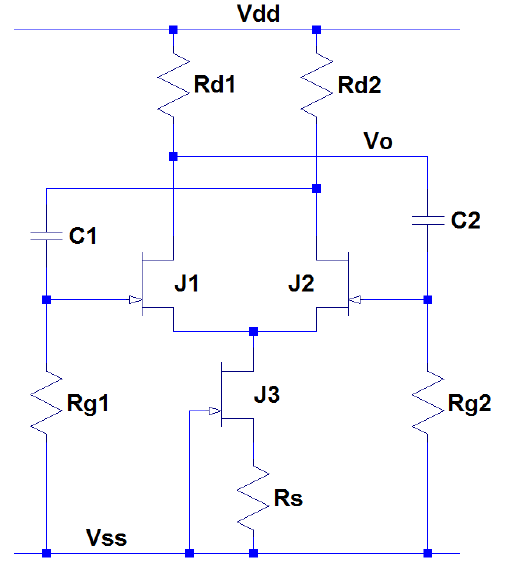
Figure 8. Circuit schematics of SiC JFET astable multivibrator whose frequency is temperature-dependent.